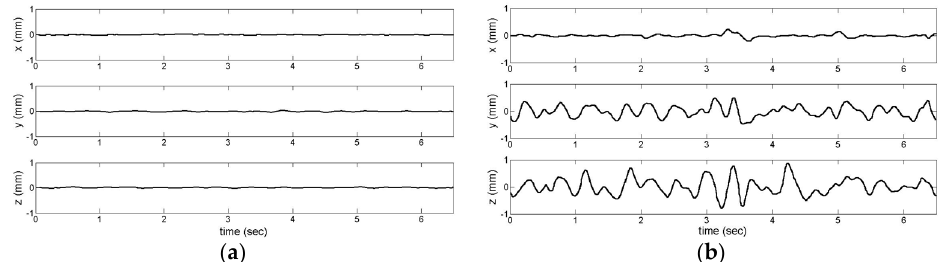
Figure 5. Position fluctuations at two flow speeds: ( a ) 10 m/s, ( b ) 37 m/s.